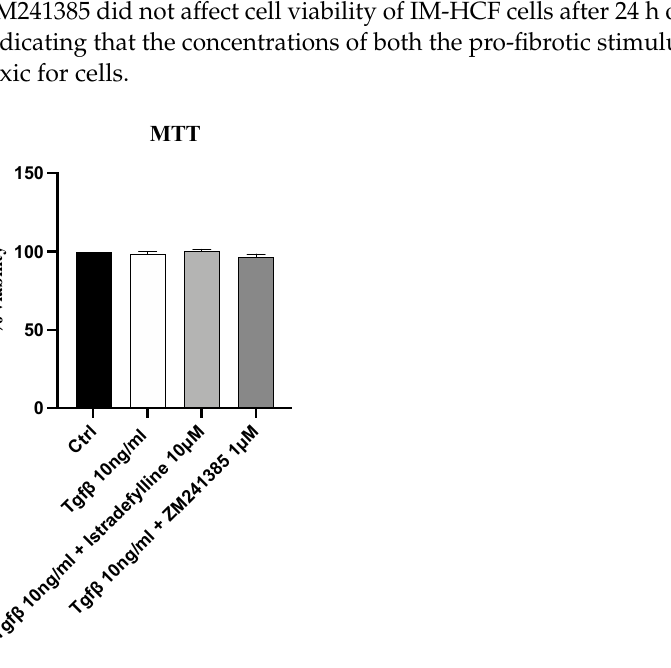
Figure 1. Cytotoxicity assay evaluated with MTT in the IM-HCF cell line stimulated with TGF- β (10 ng/mL) alone and TGF- β followed by Istradefylline (10 µM) or ZM241385 (1 µM) for 24 h. Values are expressed as the means and SD of five experiments.